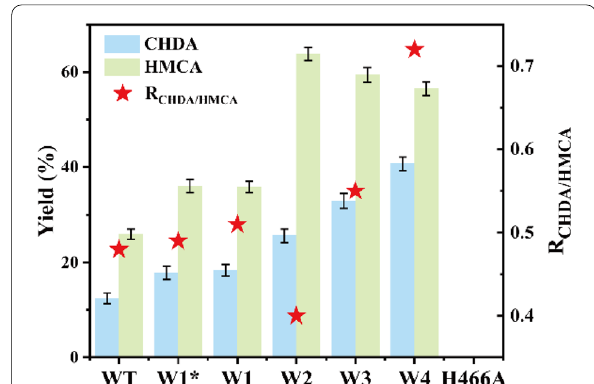
Fig. 4 Directed evolution of the Ac CO for primary alcohol oxidation of CHDM. Reactions were performed in recombinant E. coli (30 g whole cell catalyst) and 5 mM CHDM in 1 mL air-saturated potassium phosphate buffer (100 mM, pH 8.0) at 30 °C for 12 h (600 rpm). The yield was determined by